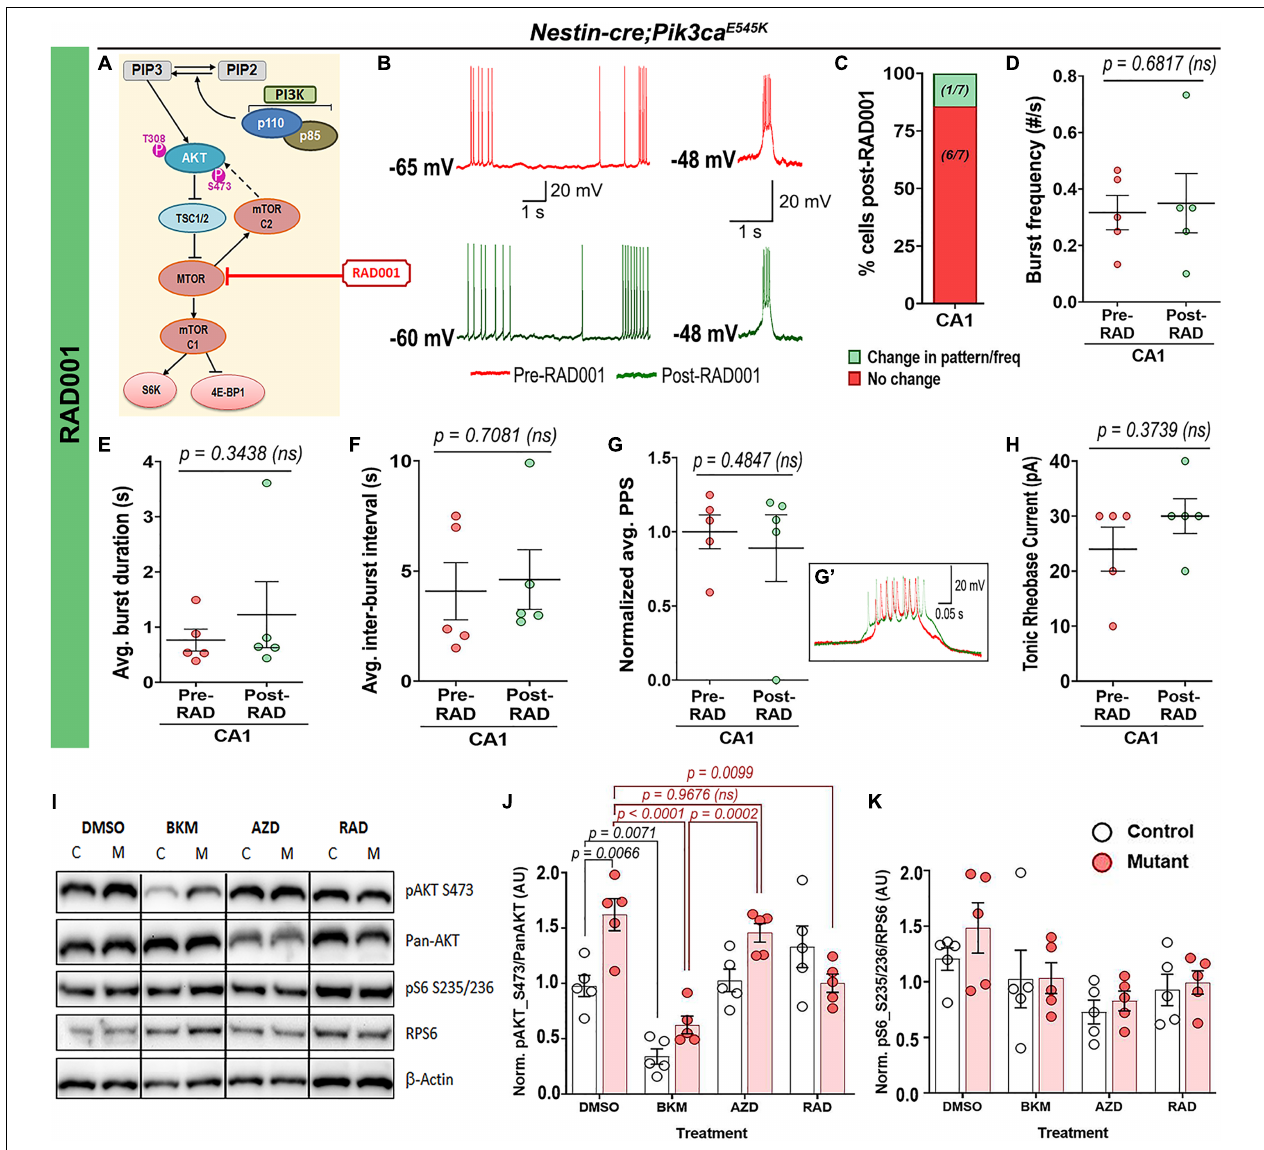
FIGURE 7 | Acute treatment with RAD001 has no overt effect on mutant neuronal physiological properties. (A) Schematic of simplified PI3K-AKT-MTOR pathway, marking target of action for RAD001. Representative traces demonstrate action of RAD001 (B) on Nestin-cre;Pik3ca E 545 K hippocampal neurons, ranging from being unaffected to change in frequency/pattern to silencing, as quantitated, respectively, in panel (C) . (D–H) Acute RAD001 treatment had no overt effect on the mutant burst frequency ( t = 0.4414, df = 4), average burst duration ( t = 1.073, df = 4), inter-burst interval ( t = 0.4023, df = 4), rheobase current ( t = 1.000, df = 4) or PPS ( t = 0.7692, df = 4). (I) Representative Western blots bands of pAKT_S473, pan-AKT, pS6-S235/236 and RPS6 (total S6) are demonstrated across different treatment (DMSO, BKM120, AZD5363, and RAD001). (J,K) Quantifications of normalized ratios of phosphoproteins over total proteins showed significant reduction of pAKT_S473 in response to acute BKM120 and RAD001 treatment but not post-AZD5363 ( F = 22.98, df = 32); pS6_S235/236 in mutant had a decreasing trend in response to all pathway drugs ( F = 4.485, df = 32). Data is represented as mean ± SEM scatter plots and bar graphs; differences were considered significant at p < 0.05; ns, not significant. Each pair of pre-RAD (spontaneous recording) and post-RAD values (from final 5 min recording) were obtained from the same cell (D–H) . Scale bars: 1 s, 20 mV (B) ; 0.05 s, 20 mV (G’)